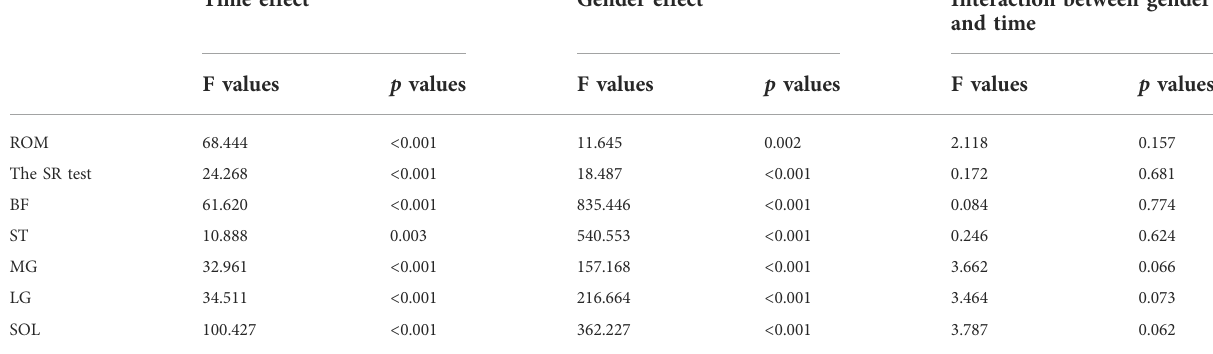
TABLE 2 Effects of time, gender, and their